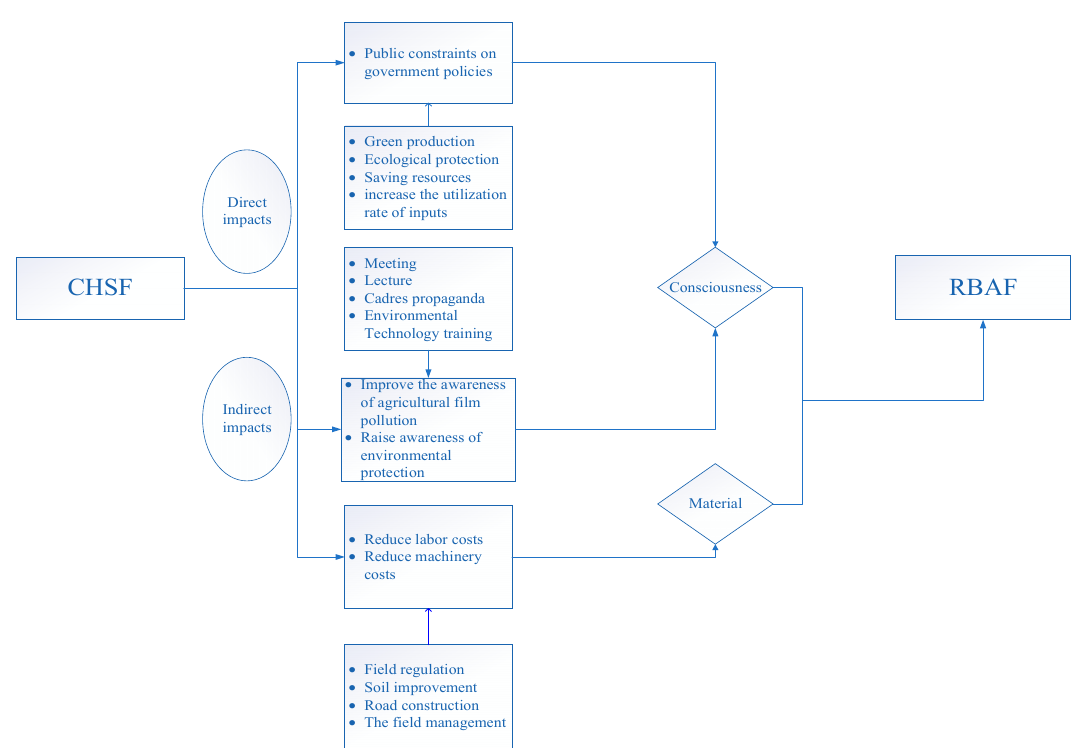
Figure 1. Theoretical analysis framework of the impact of CHSF on RBAF.